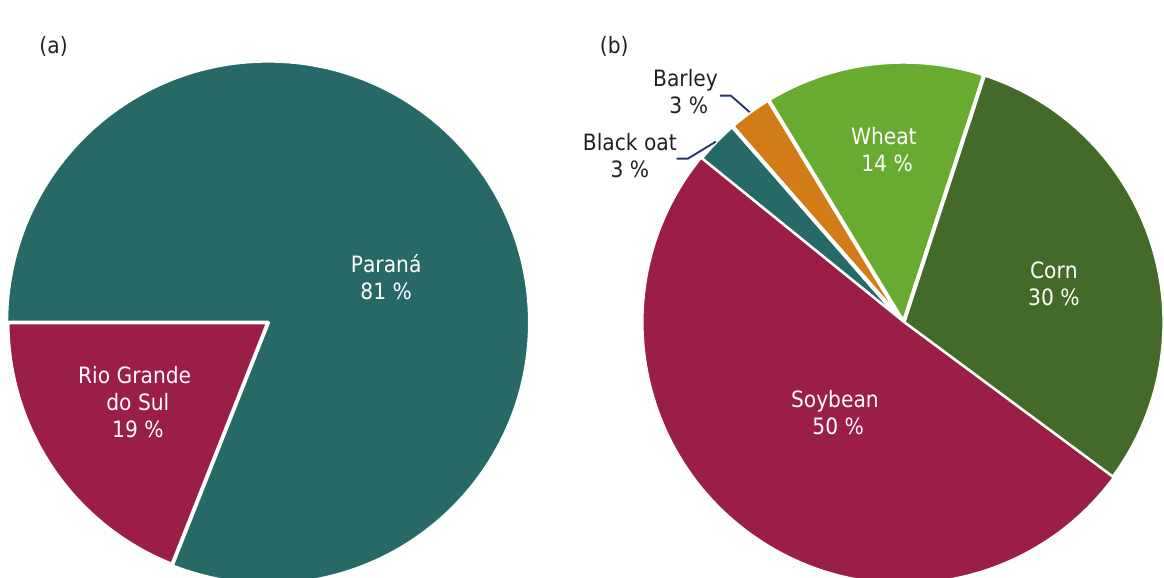
Figure 2. Relative frequency of growing seasons in each Brazilian state (a) and for each crop (b) studied with regard to yield response to gypsum in subtropical soils under no-tillage in Southern